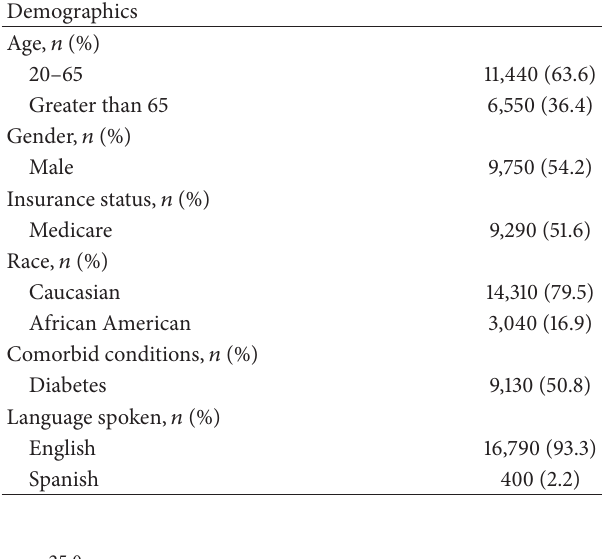
Table 1: Demographics for patients with cirrhosis.